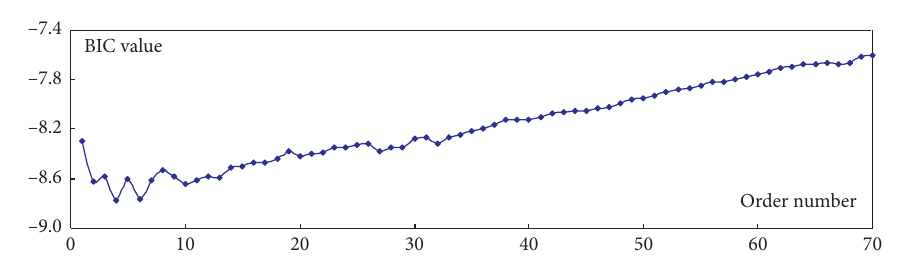
Figure 7: Relationship between AIC values and p .